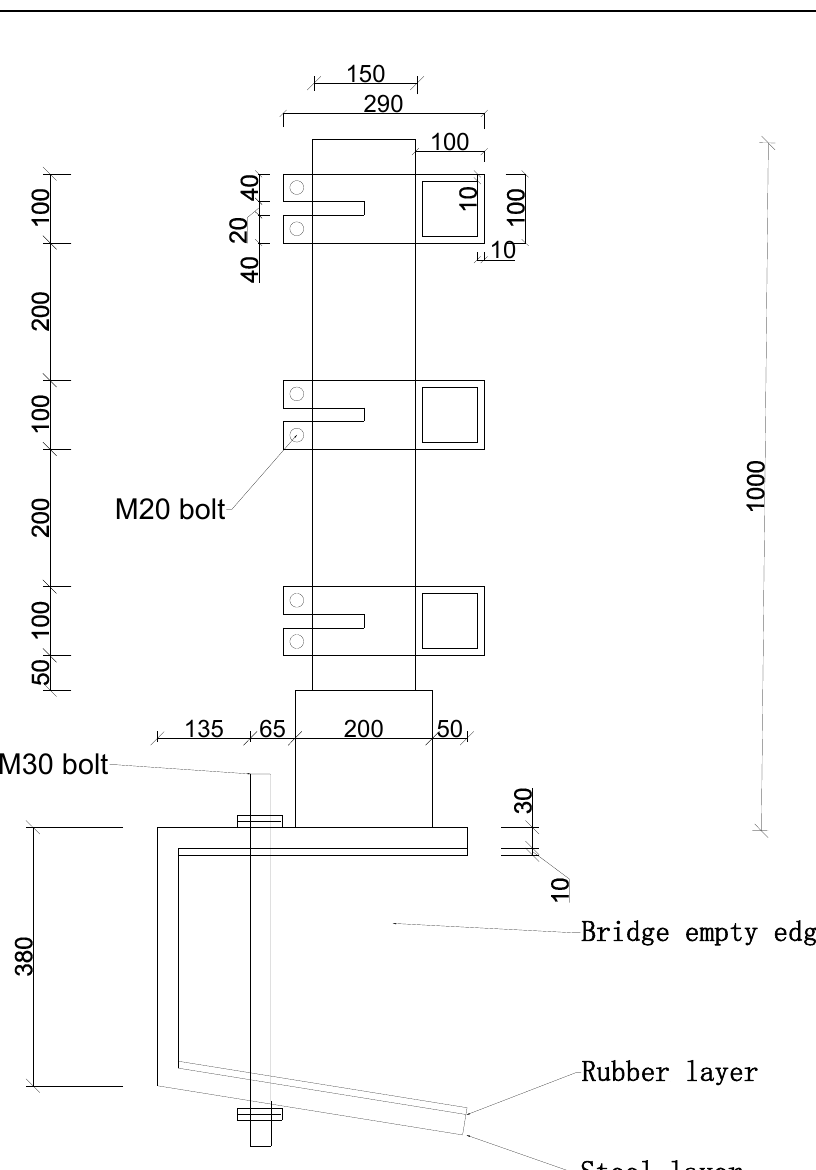
Figure A1. Sectional view of a guardrail.